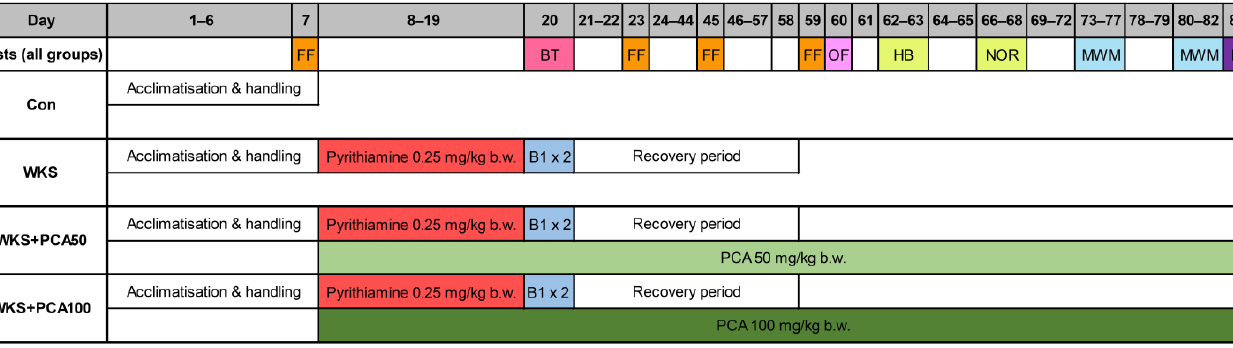
Figure 1. Experimental design, with timeline of treatments and behavioural